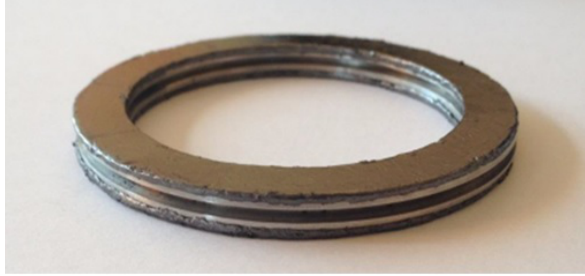
Figure 14: Gasket after the compression test